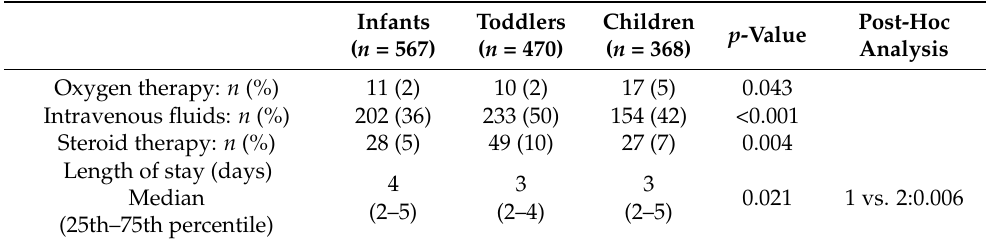
Table 4. The disease outcome for 1405 hospitalized pediatric patients with COVID-19 according to age.